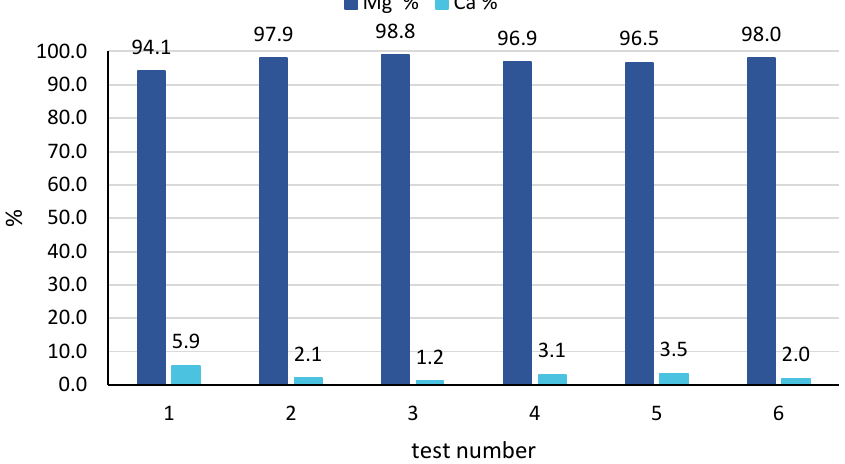
Figure 9. Solid purity expressed as percentage of magnesium and calcium ions, as an average of all samples collected in all tests 1–6.